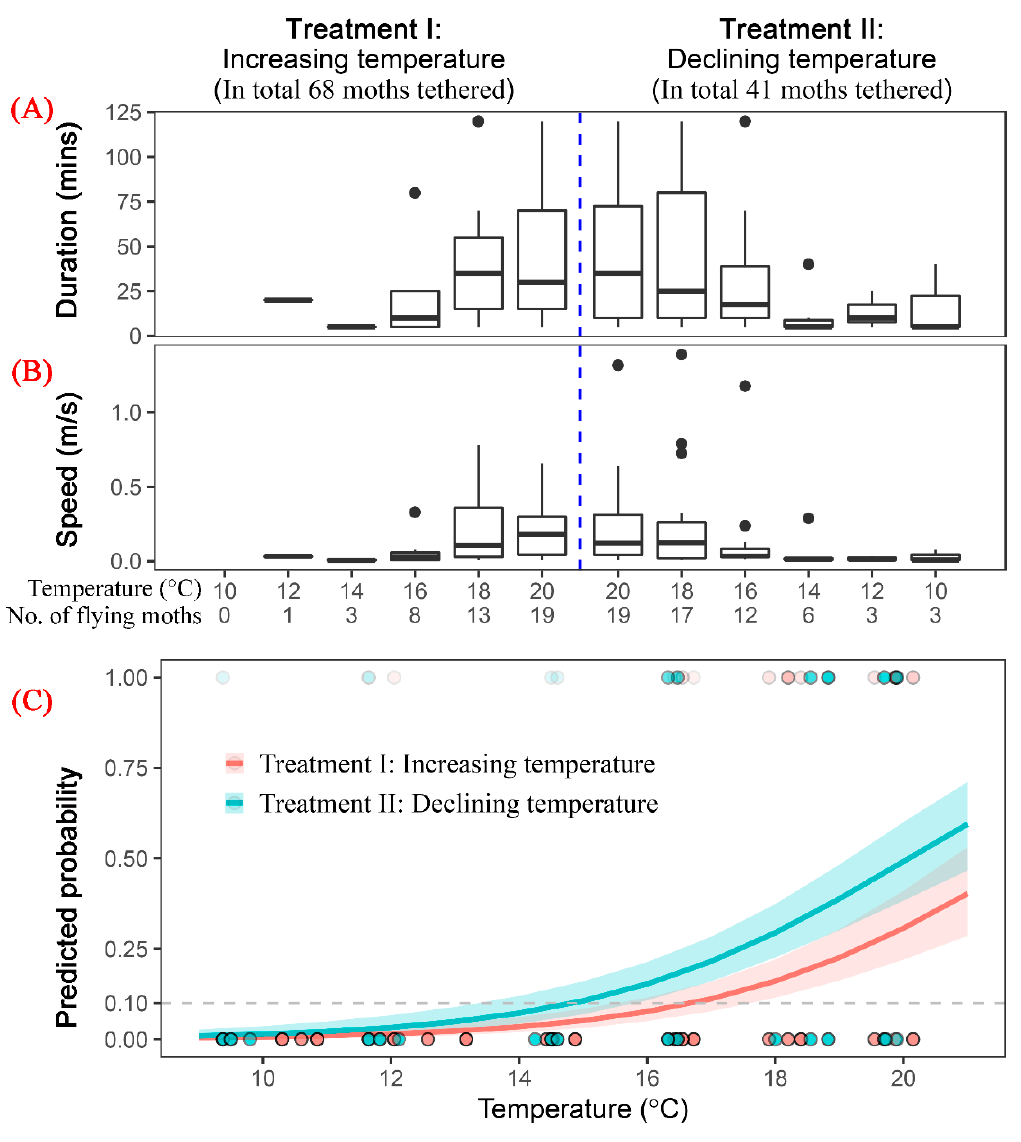
Figure 3. The flight duration ( A ) and speed ( B ) of S. frugiperda under different temperatures. ( C ) The smooth curve of logistic GLM models.